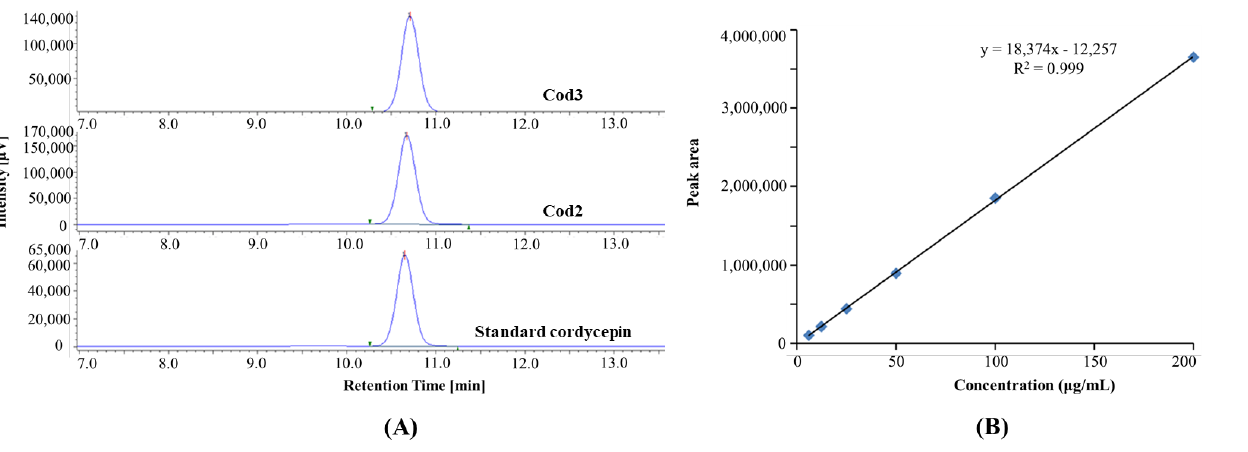
Figure 4. HPLC chromatogram of purified and standard cordycepin ( A ), and linear curve of standard cordycepin ( B ).